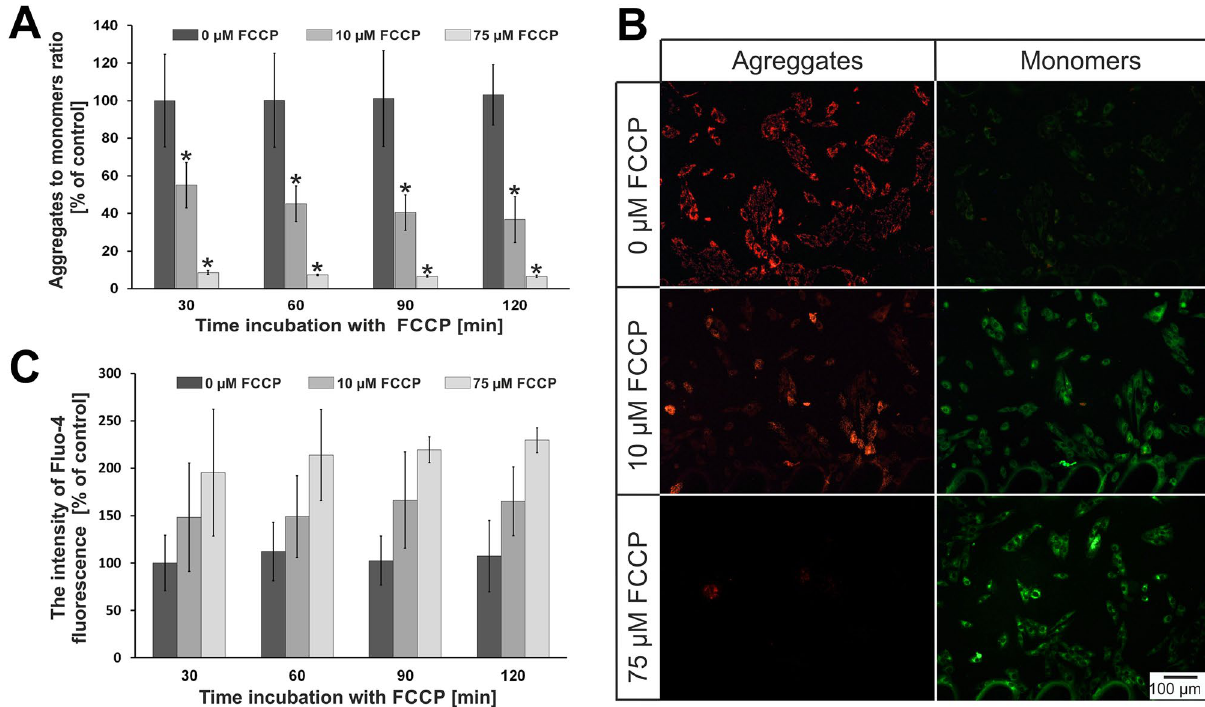
Figure 4. ( A ) The results of changes in mitochondrial membrane potential for H9C2 cells. N ≥ 3, asterisks indicate p < 0.05. ( B ) H9C2 cells after 120 min incubation with FCCP. The cells were stained with JC-1. ( C ) The results of changes in concentration of intracellular calcium ions for H9C2 cells.